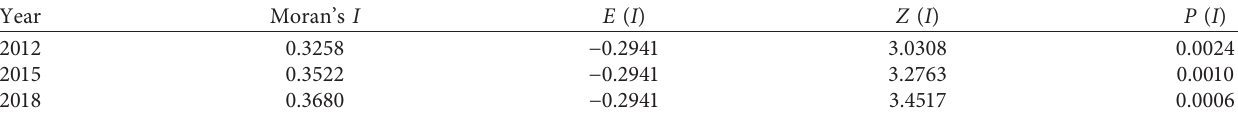
Table 2: Moran’s I of IGD in YRB in 2012, 2015, and